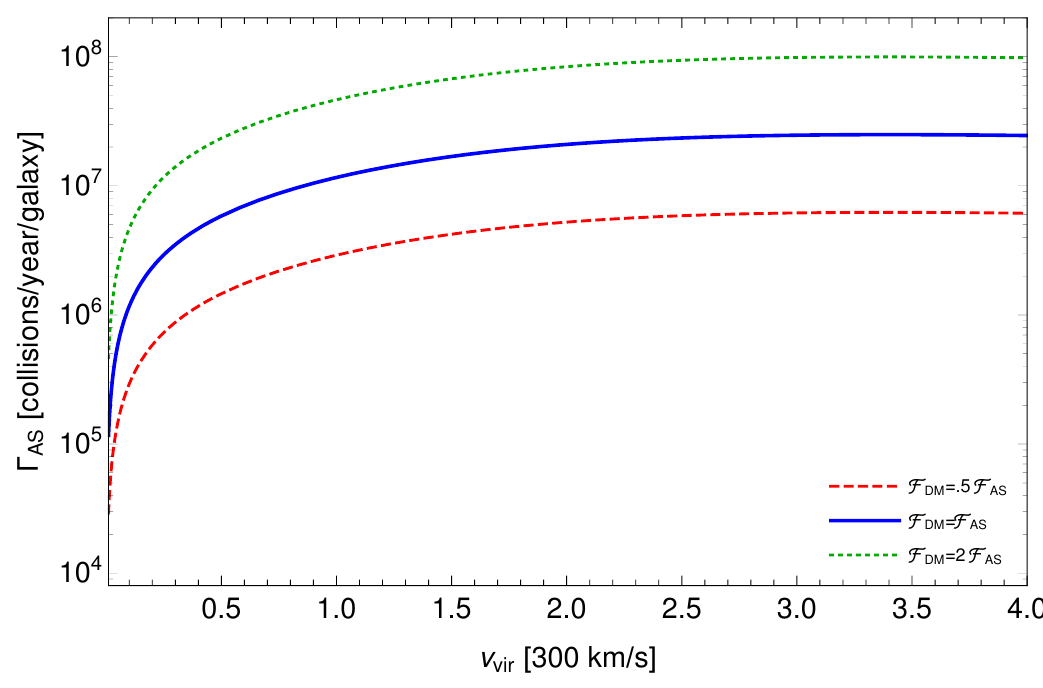
Figure 2 . The collision rate of two ASts as a function of (cid:17) = v vir = (300 km/s), evaluated at di(cid:11)erent values of F DM = F AS